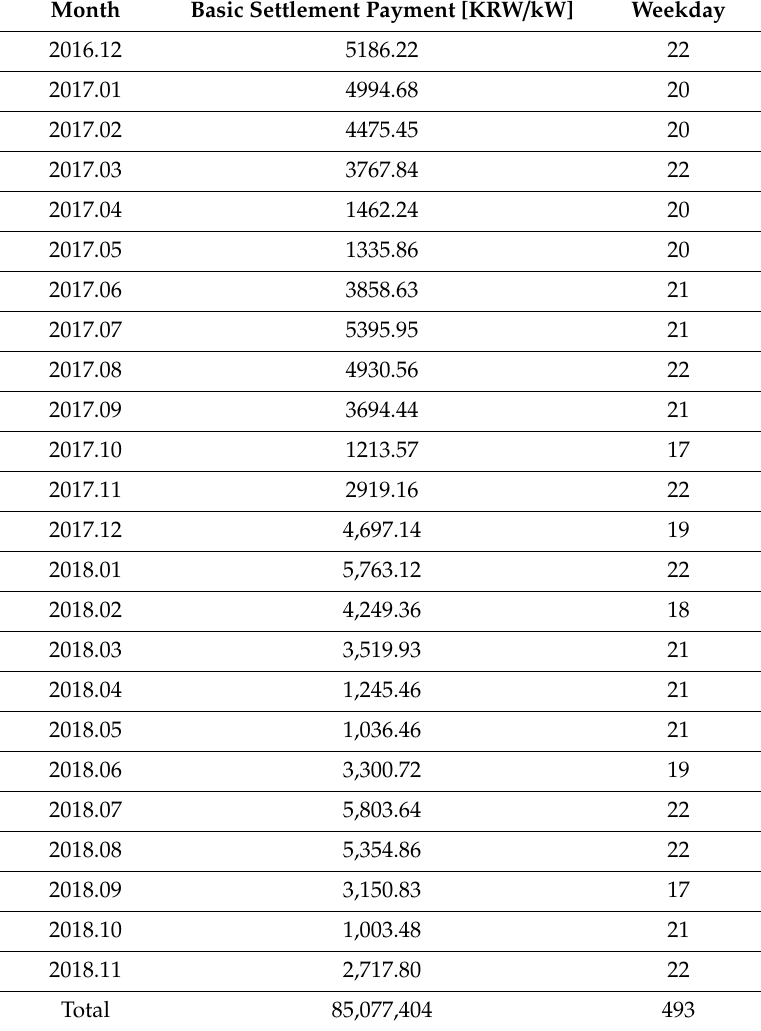
Table 4. Monthly basic settlement payment